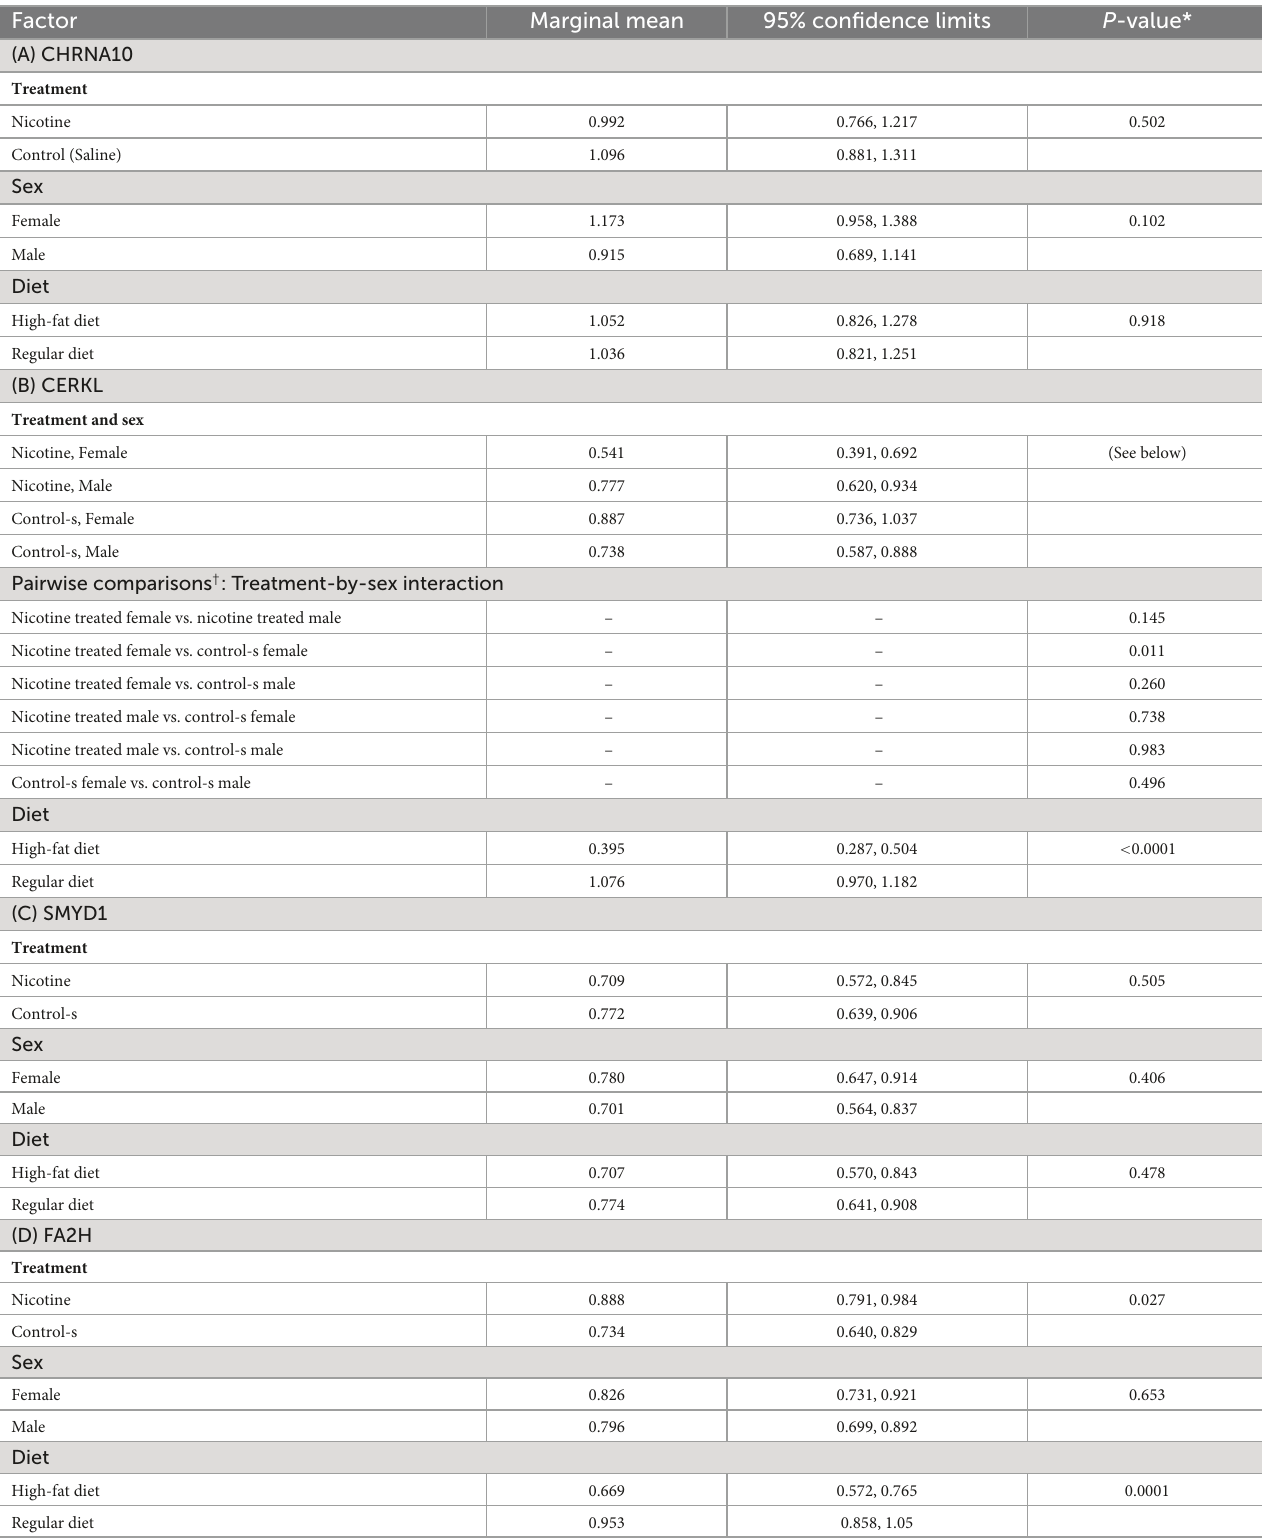
TABLE 2 Results of the three-way analysis of variance (ANOVA) with treatment, sex, and diet (regular diet and high-fat diet) of fold change in the expression of (A) CHRNA10 ( N = 46), (B) CERKL ( N = 47), (C) SMYD1 ( N = 47), (D) FA2H ( N = 47).